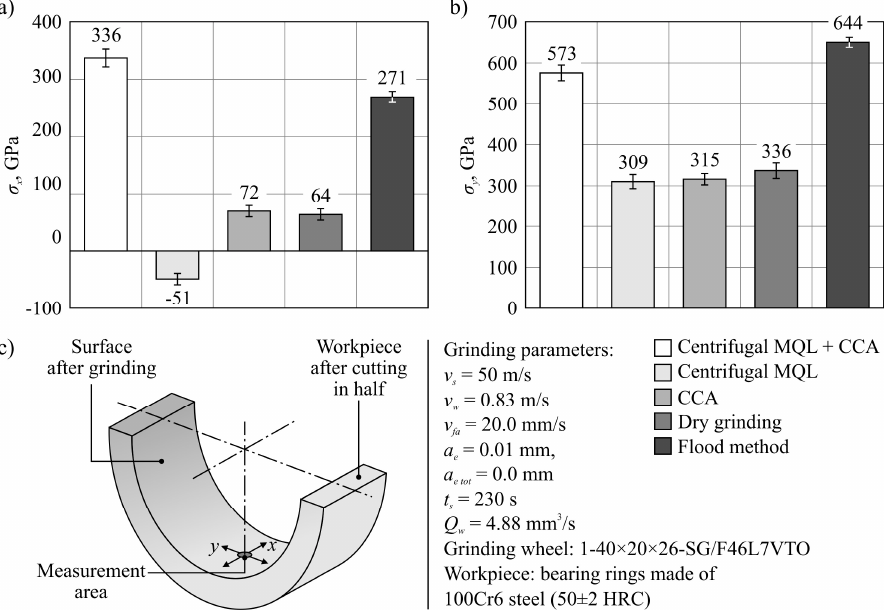
Figure 9. Values of residual stress in the surface layer of workpieces machined with the use of the five tested cooling and lubrication methods of the grinding zone: ( a ) in the x direction; ( b ) in the y direction; ( c ) diagram illustrating the x and y measurement directions .